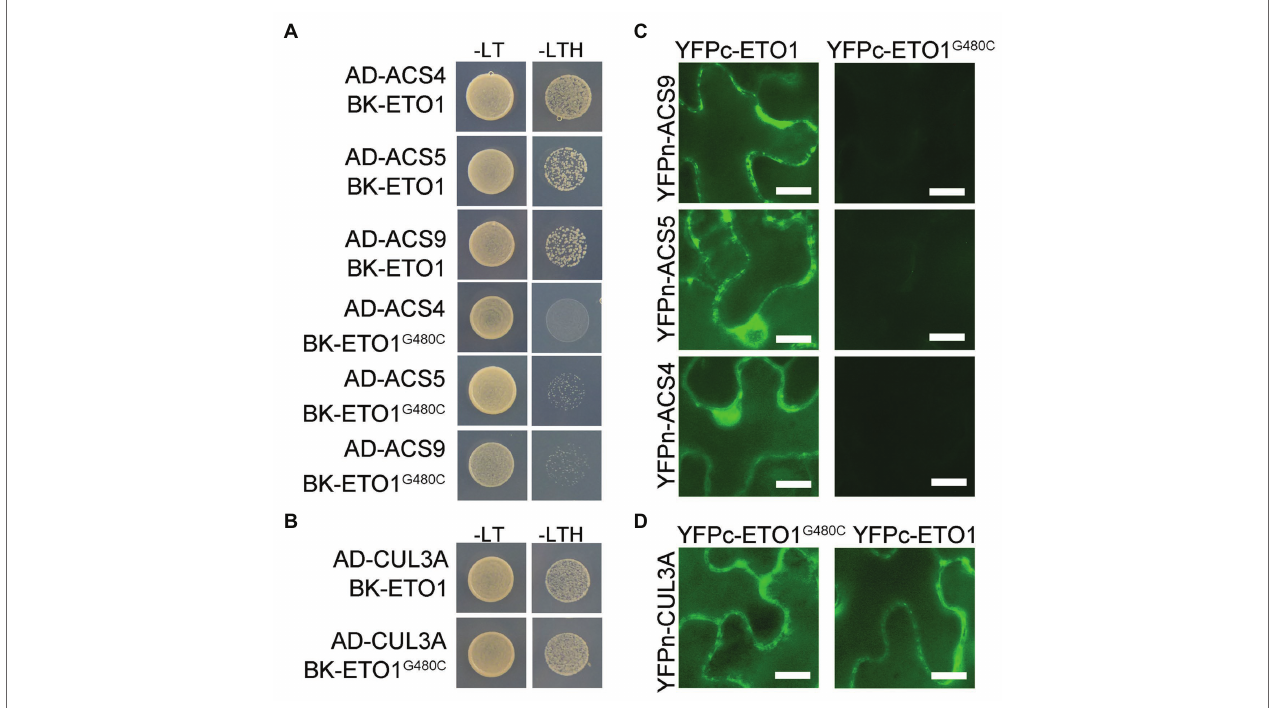
FIGURE 5 | Interaction between ETO1 and type 2 1-aminocyclopropane-1-carboxylic acid (ACC) synthases (ACSs) is suppressed. (A) yeast two hybrid (Y2H) assay results between ETO1 and type 2 ACSs, including ACS4, ACS5, and ACS9. (B) Y2H results between ETO1 and CUL3A. (C) Bimolecular fluorescence complementation (BiFC) results between ETO1 and type 2 ACSs. (D) BiFC results of ETO1 and CUL3A. Bars = 10 μ